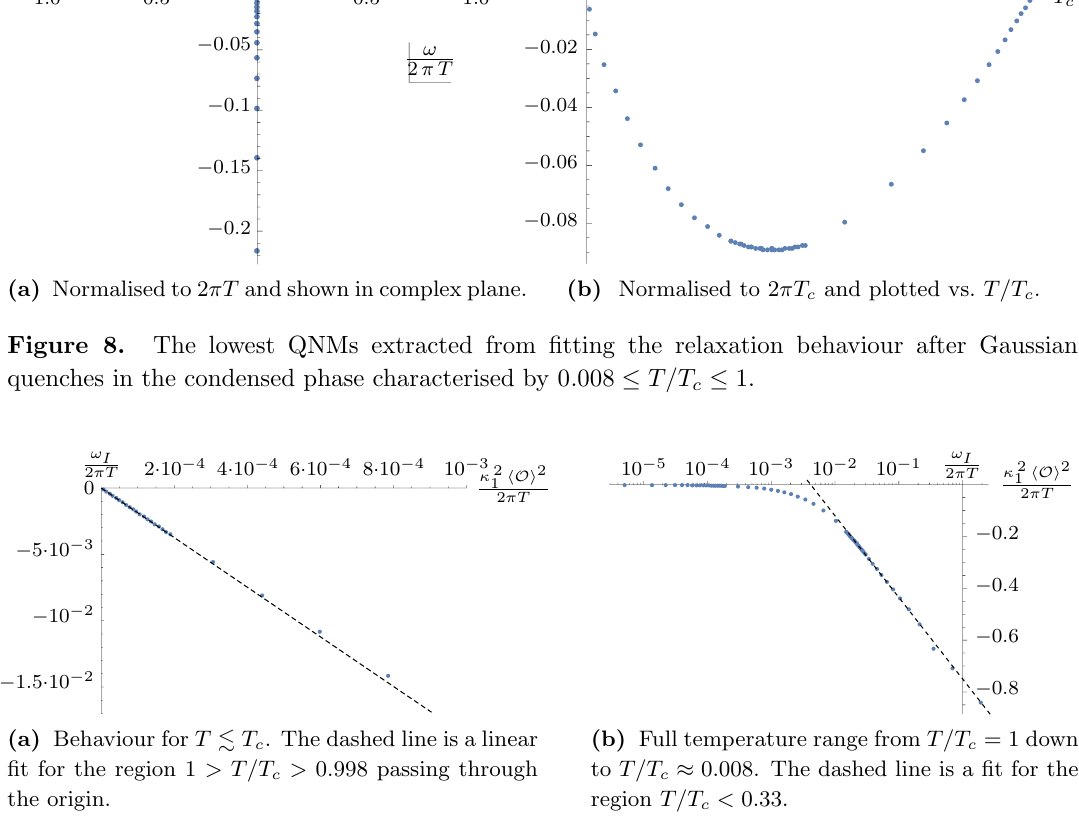
hOi 2 in the condensed 1